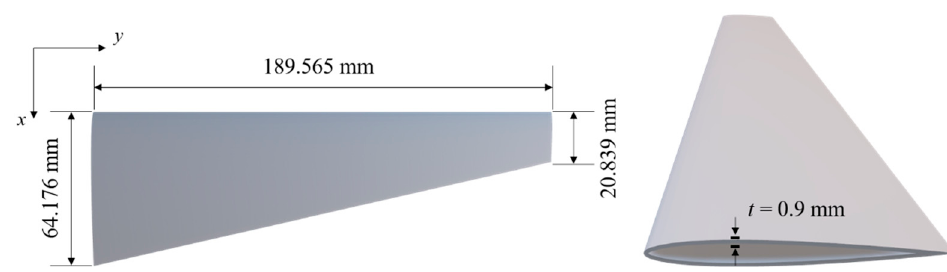
Figure 3. Planform ( left ) and cross section at root ( right ) of the wing model.